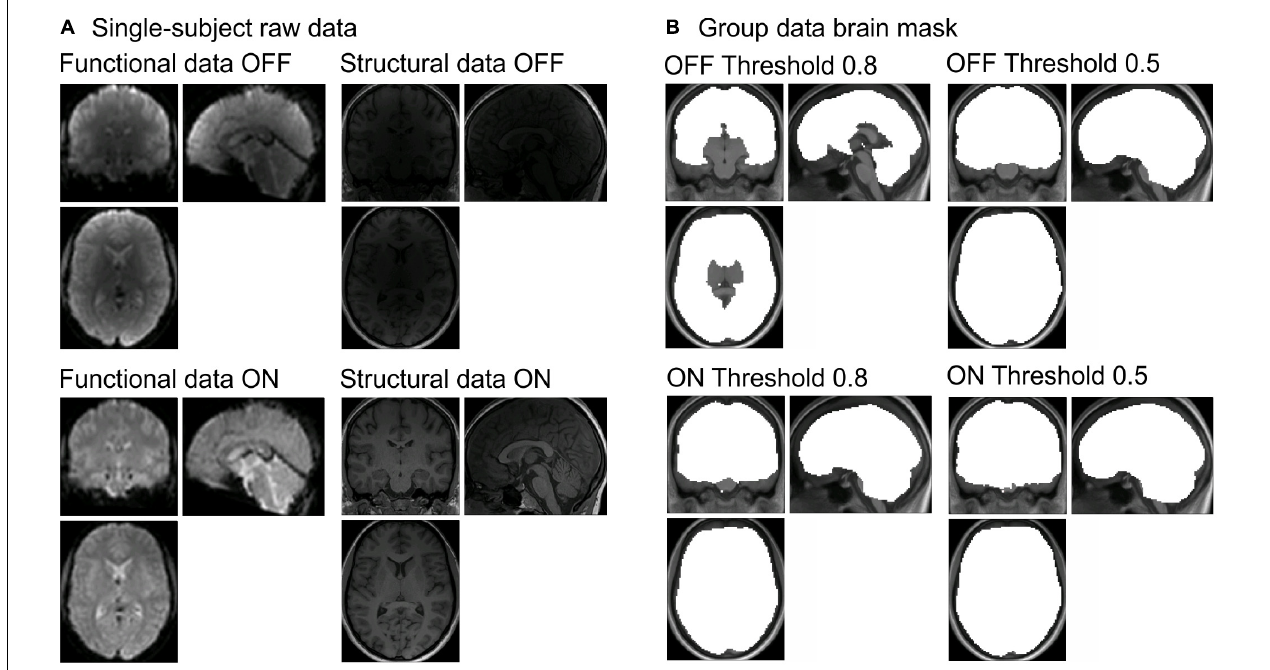
FIGURE 1 | (A) Raw data for functional (left column) and structural data (right column) with the prescan normalize filter OFF (first row) and ON (second row) from one participant. (B) Differences in brain masks for the different masking thresholds (0.8 = original in left column and 0.5 = adjusted in right column) between prescan normalize OFF (first row) and ON (second row). Brain masks are created during the whole-brain analyses with SPM. SPM, Statistical Parametric